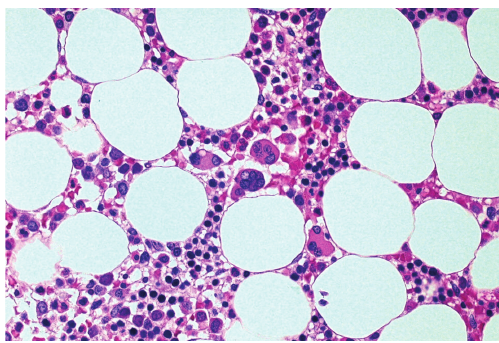
Figure 4: Marked megakaryocyte nuclear fragmentation in a nor- mocellular marrow, bone marrow trephine H&E × 400.